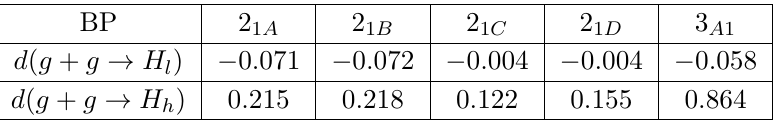
Table 7 . The coe(cid:14)cient in front of the scale dependent logarithm of the percentage correction is shown for the benchmark points that are in the alignment limit ( c (cid:11)(cid:12) = 0).